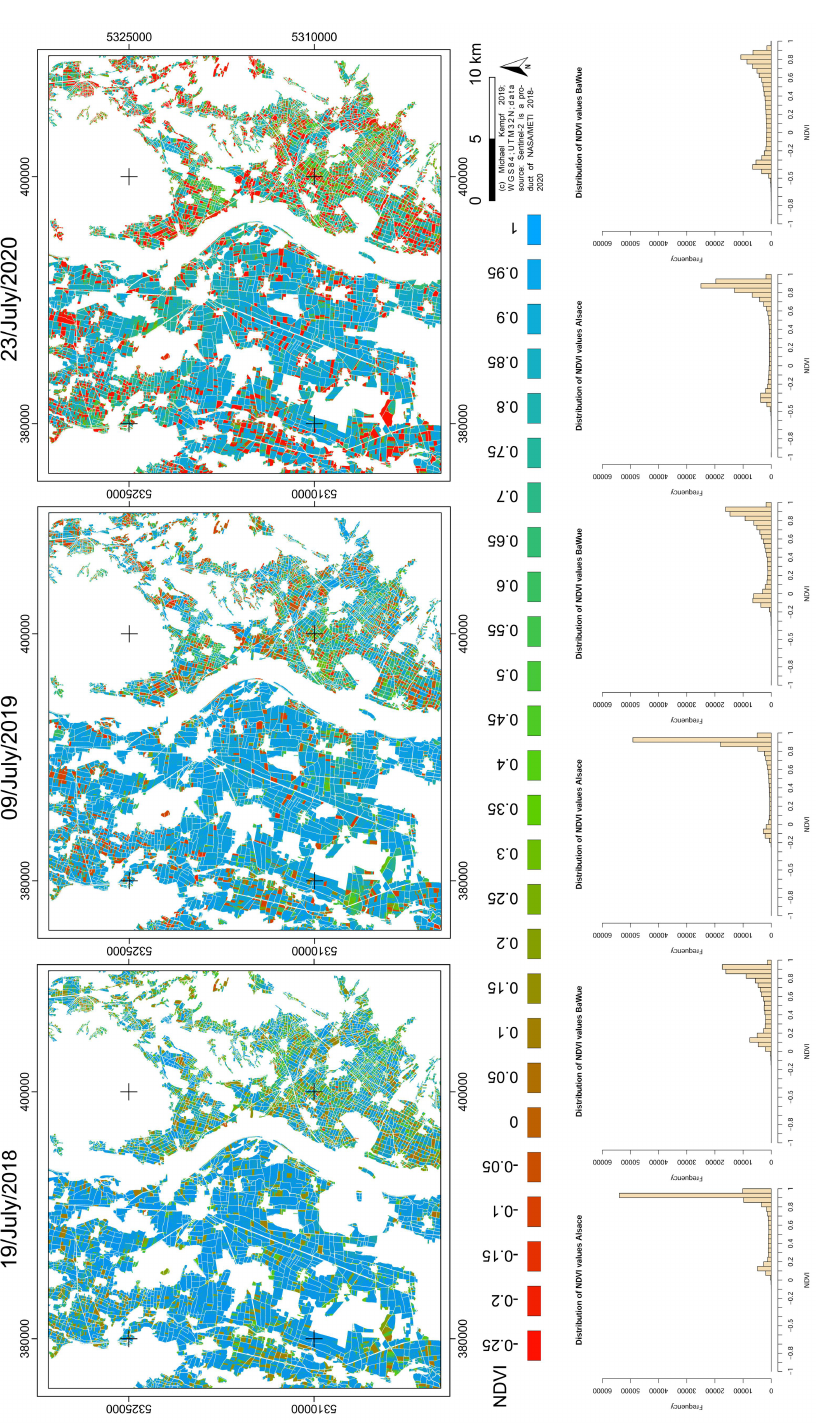
Figure 8. NDVI times series from 19 July 2018, 9 July 2019, and 23 July 2020 showing strong regional differences in plant species physical conditions. In the image from the 19 July 2018, cloud coverage deriving from emitted water vapor of the nuclear power plant at Fessenheim (Alsace) has been removed. All artificial built-up, roads, railway tracks, water courses, and water surfaces were buffered and removed from the data to minimize NDVI value falsification.